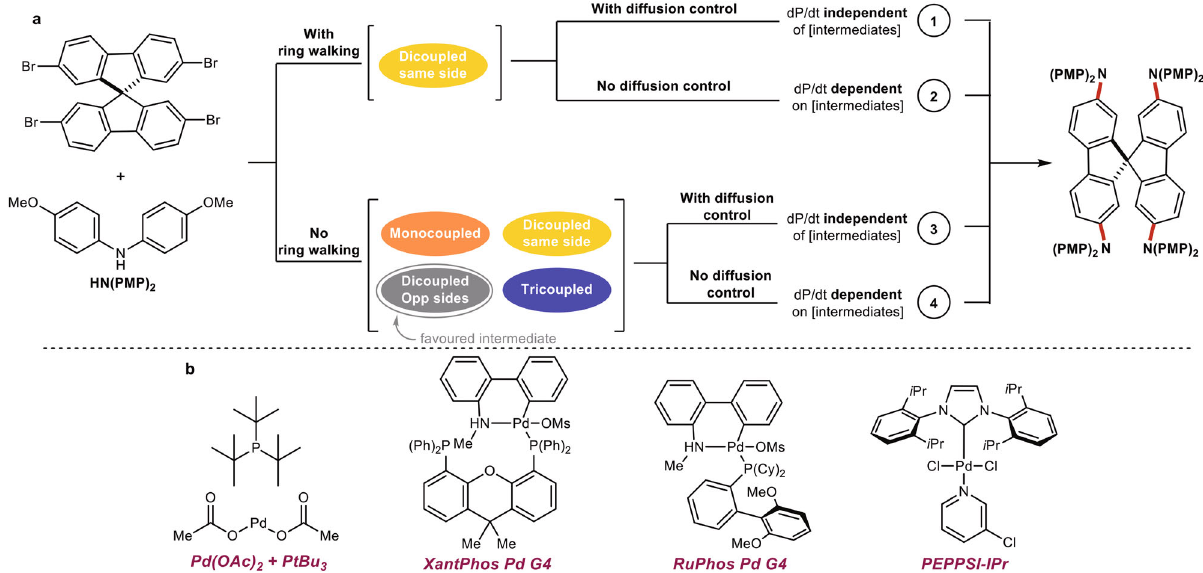
Fig. 3 Model system and targeted catalysts. a Potential mechanistic regimes present for the SpiroOMeTAD model system enabling differentiation between authentic ring walking versus solvent-mediated diffusion control. b The 4 catalyst/ligand combinations targeted for the study.